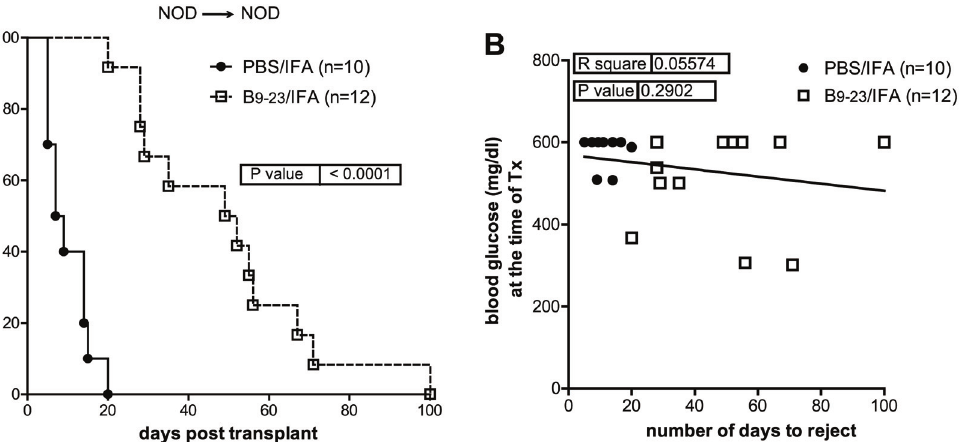
Fig 1. InsB 9 – 23 /IFA immunization temporarily controls recurrent autoimmunity in NOD mice. A, diabetic NOD mice were transplanted with islets from NOD donors (syngeneic) and treated with insB 9 – 23 /IFA or PBS/IFA. Percentage of islet graft survival after transplantation is shown. B, correlation between blood glucose levels at the time of transplant and the number of days of syngeneic islet engraftment for all mice. Each symbol represents one mouse. Survival curves were compared with the log-rank test. Correlation was done with Pearson coefficient. P values and R 2 values are indicated in the graphs.